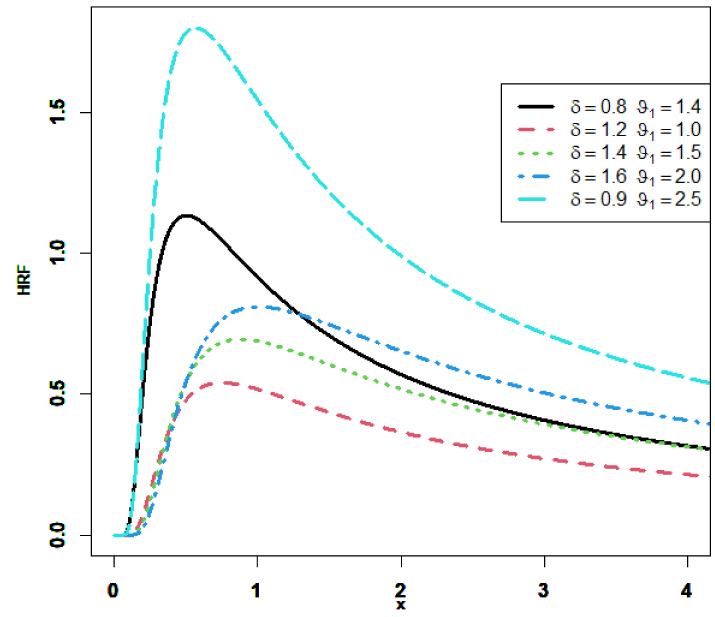
Figure 2. Plots of the HRF for the GIED for different parameter